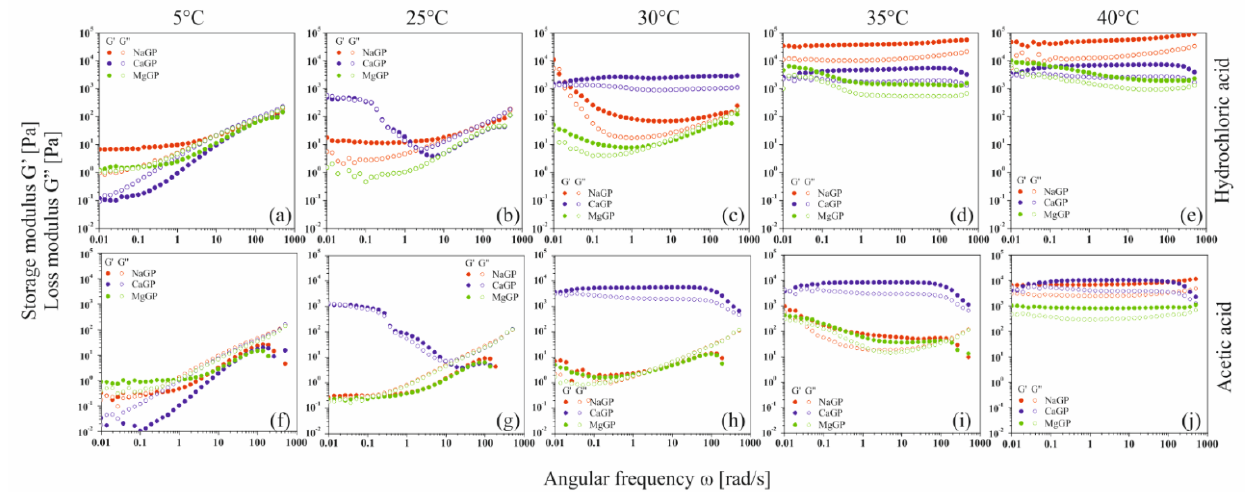
Figure 8. Mechanical spectra of chitosan chlorides ( a – e ) and acetates ( f – j ) containing disodium, calcium, or magnesium glycerophosphate, respectively.